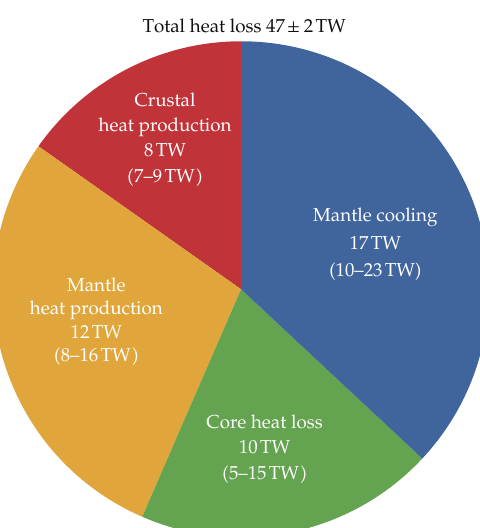
Figure 4: Present-day thermal budget of the Earth, which assumes a geochemical BSE composition (cid:5) ∼ 20TW of radiogenic power (cid:6) . Adapted from (cid:3) 40, 43 (cid:4) . See also (cid:3) 104 (cid:4)